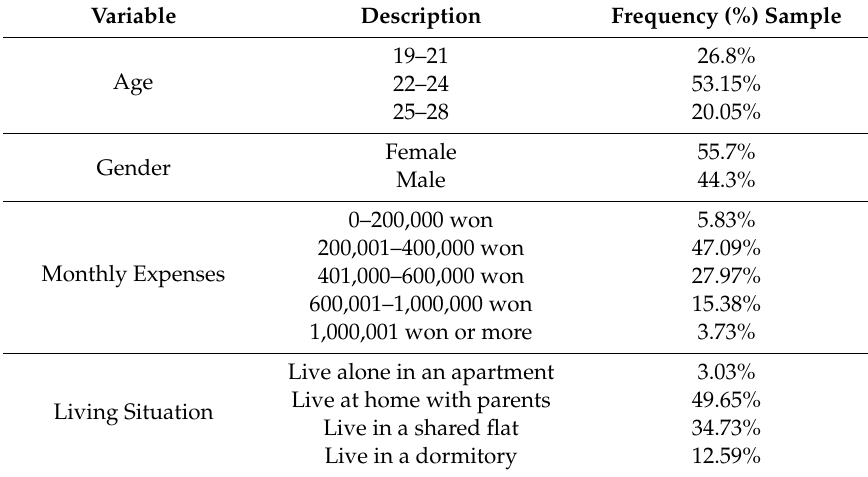
Table 1. Summary of the socio-demographic data about the participating